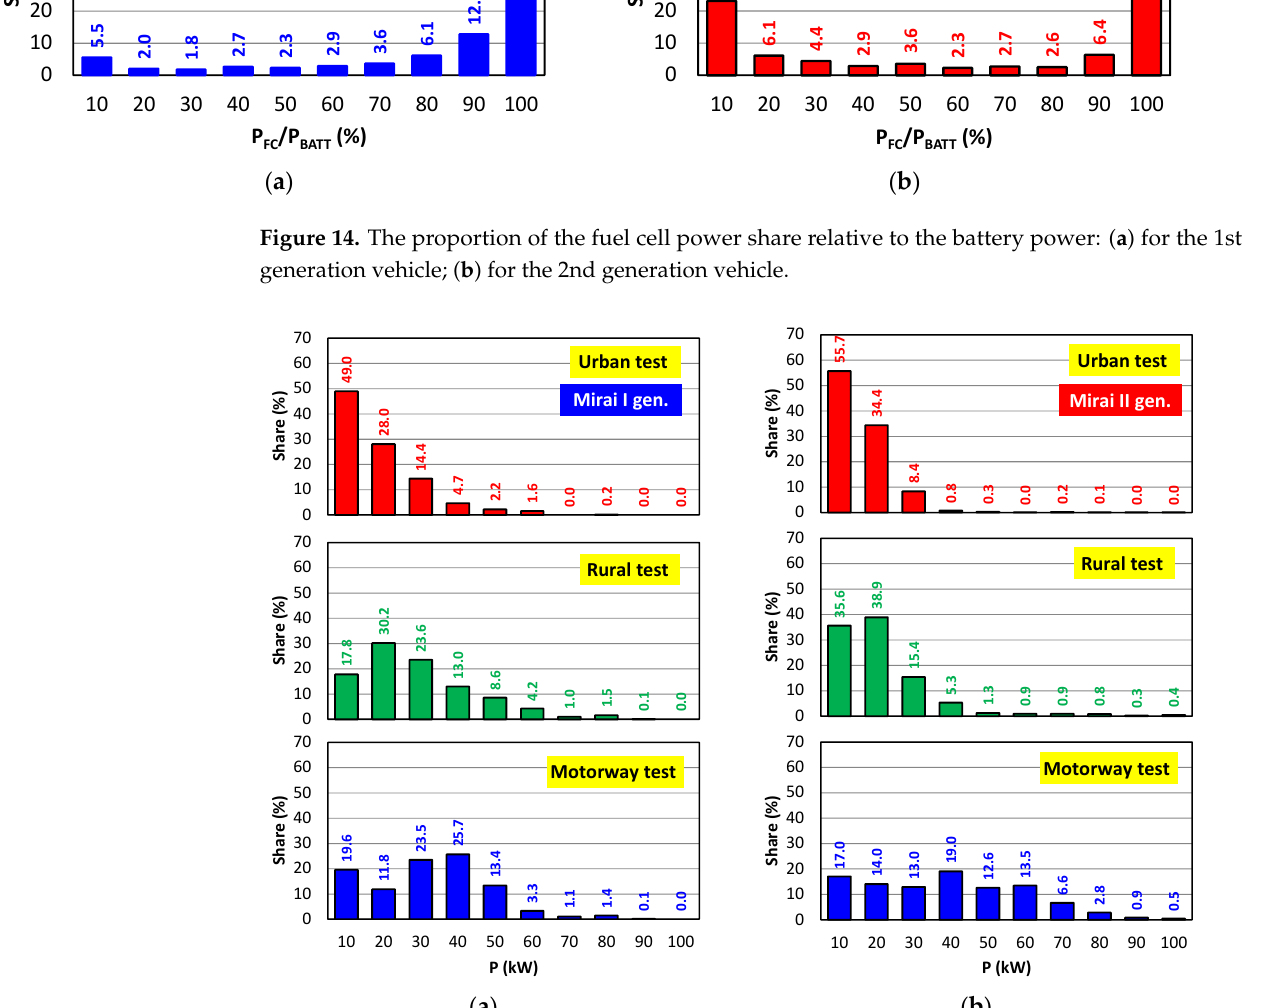
Figure 15. Fuel cells power usage conditions in particular phases of drive tests: ( a ) Mirai I gen.; ( b ) Mirai II gen.